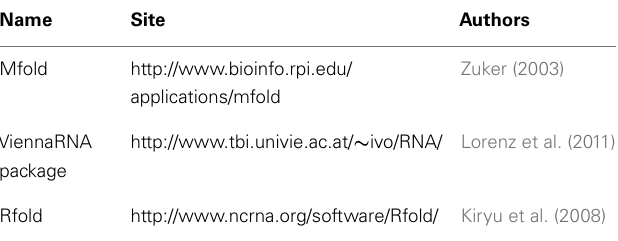
Table 7 | Secondary structure prediction